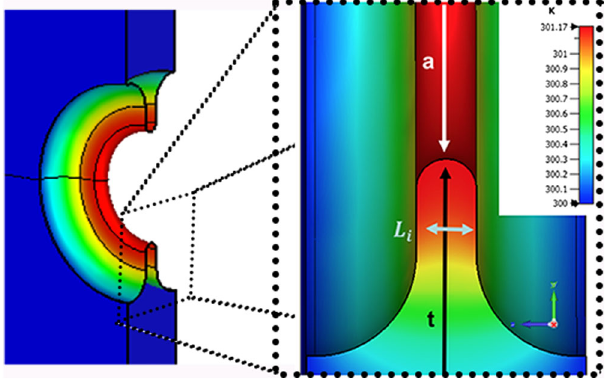
FIG. 14. Cross section of a single cell and CST ® steady-state thermal simulations results at peak gradient.